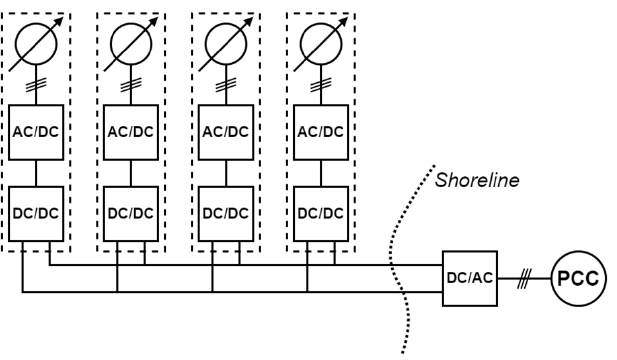
Figure 20. Topology T2. A parallel-connected DC collection grid with a separate boosting step in the marine energy converter.